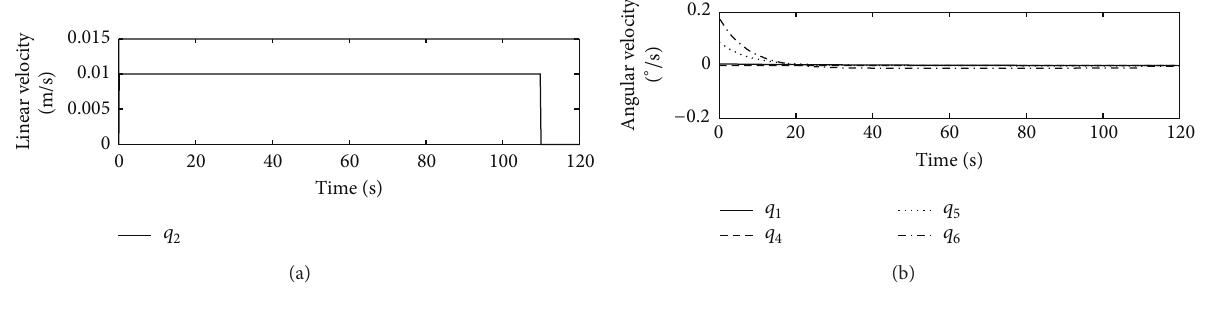
Figure 8: The computed eye-fixed approximation control input.